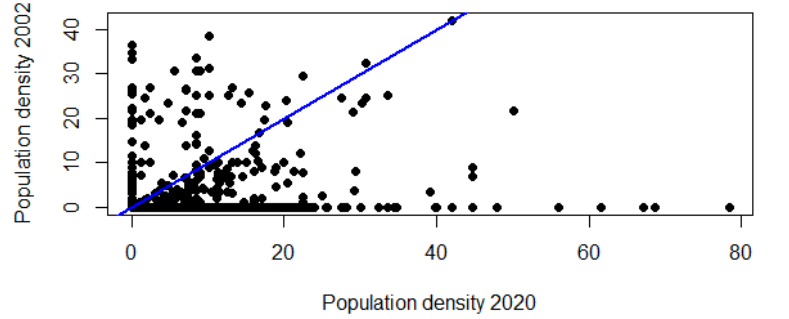
Figure 10. One-to-one plot of values that shows population density differences between 2002 and 2020. Circles below or to the right of the blue one-to-one line indicate observations with a higher value for population density in 2020 than for population density in 2002. Population density is in 10 3 .